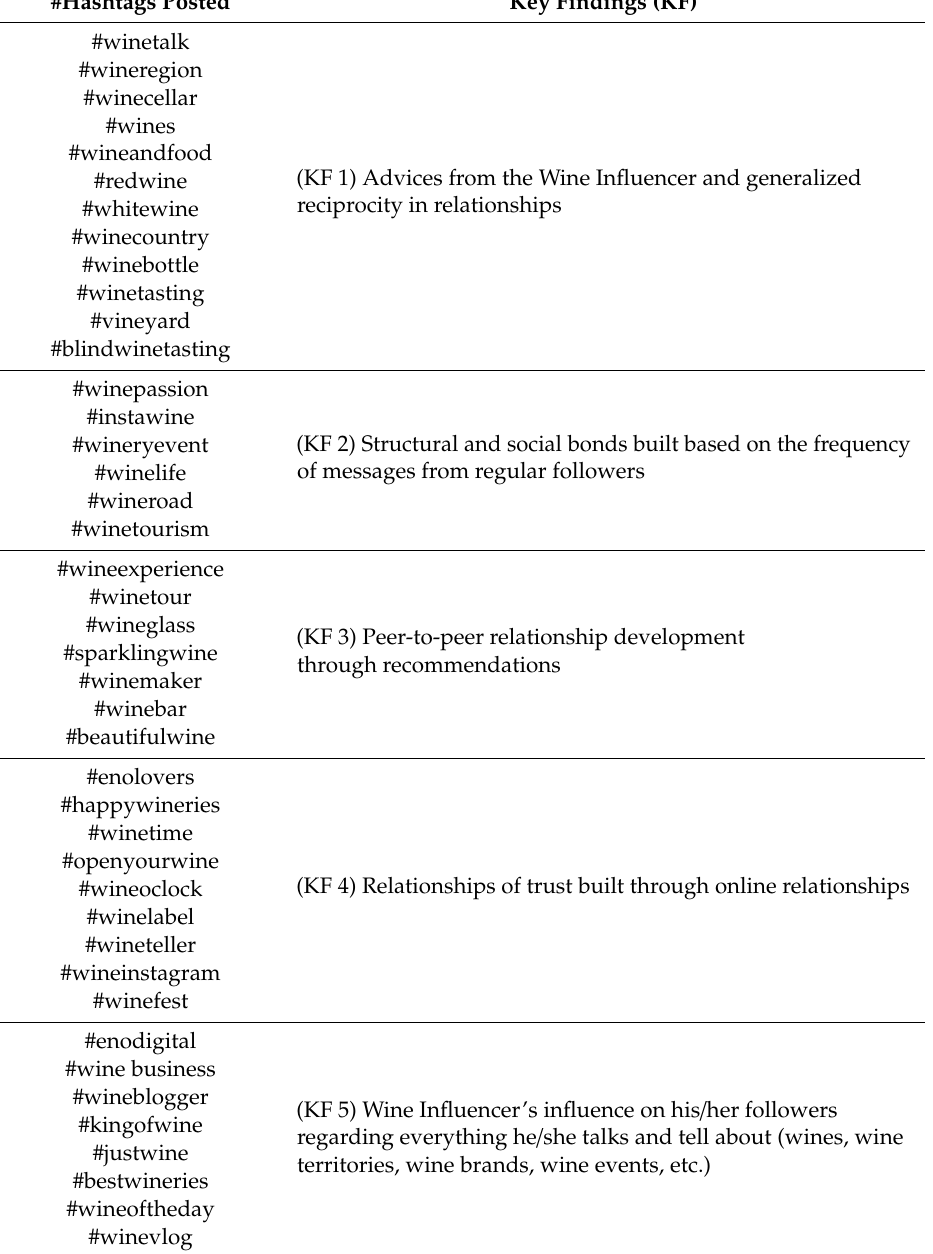
Table 2. #Hashtags occurred and Key-findings resulting from Netnographic analysis. #Hashtags Posted Key Findings